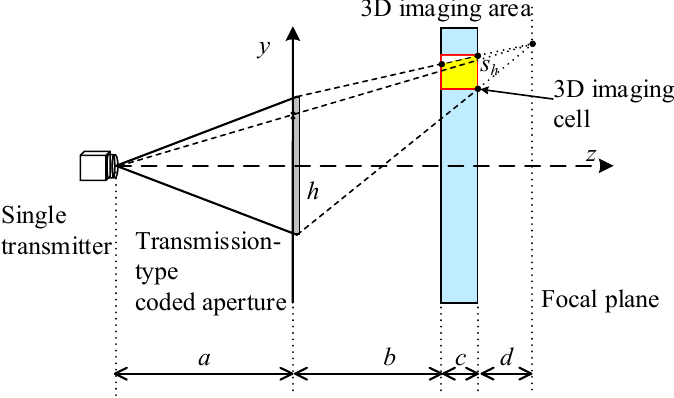
Figure 4. Schematic diagram of preliminary solution on the purposive phase modulation factor for y -axis direction, which can be abbreviated as y -PPMF.